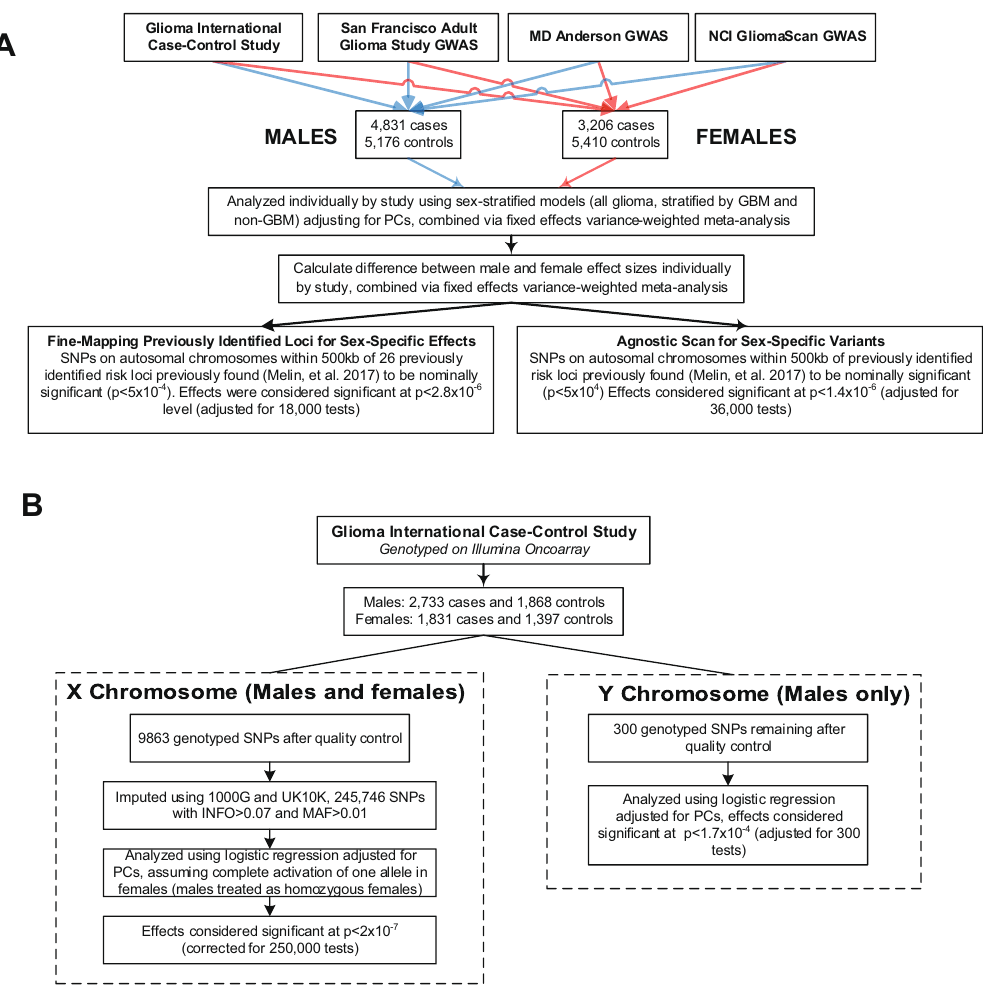
Figure 2. Study Schematic for analyses of ( A ) autosomal SNPs and ( B ) SNPs on sex